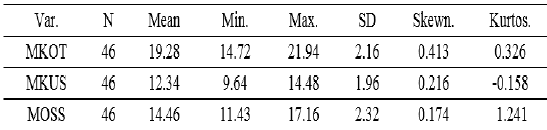
Table 2. Basic statistical parameters for assess- ing agility